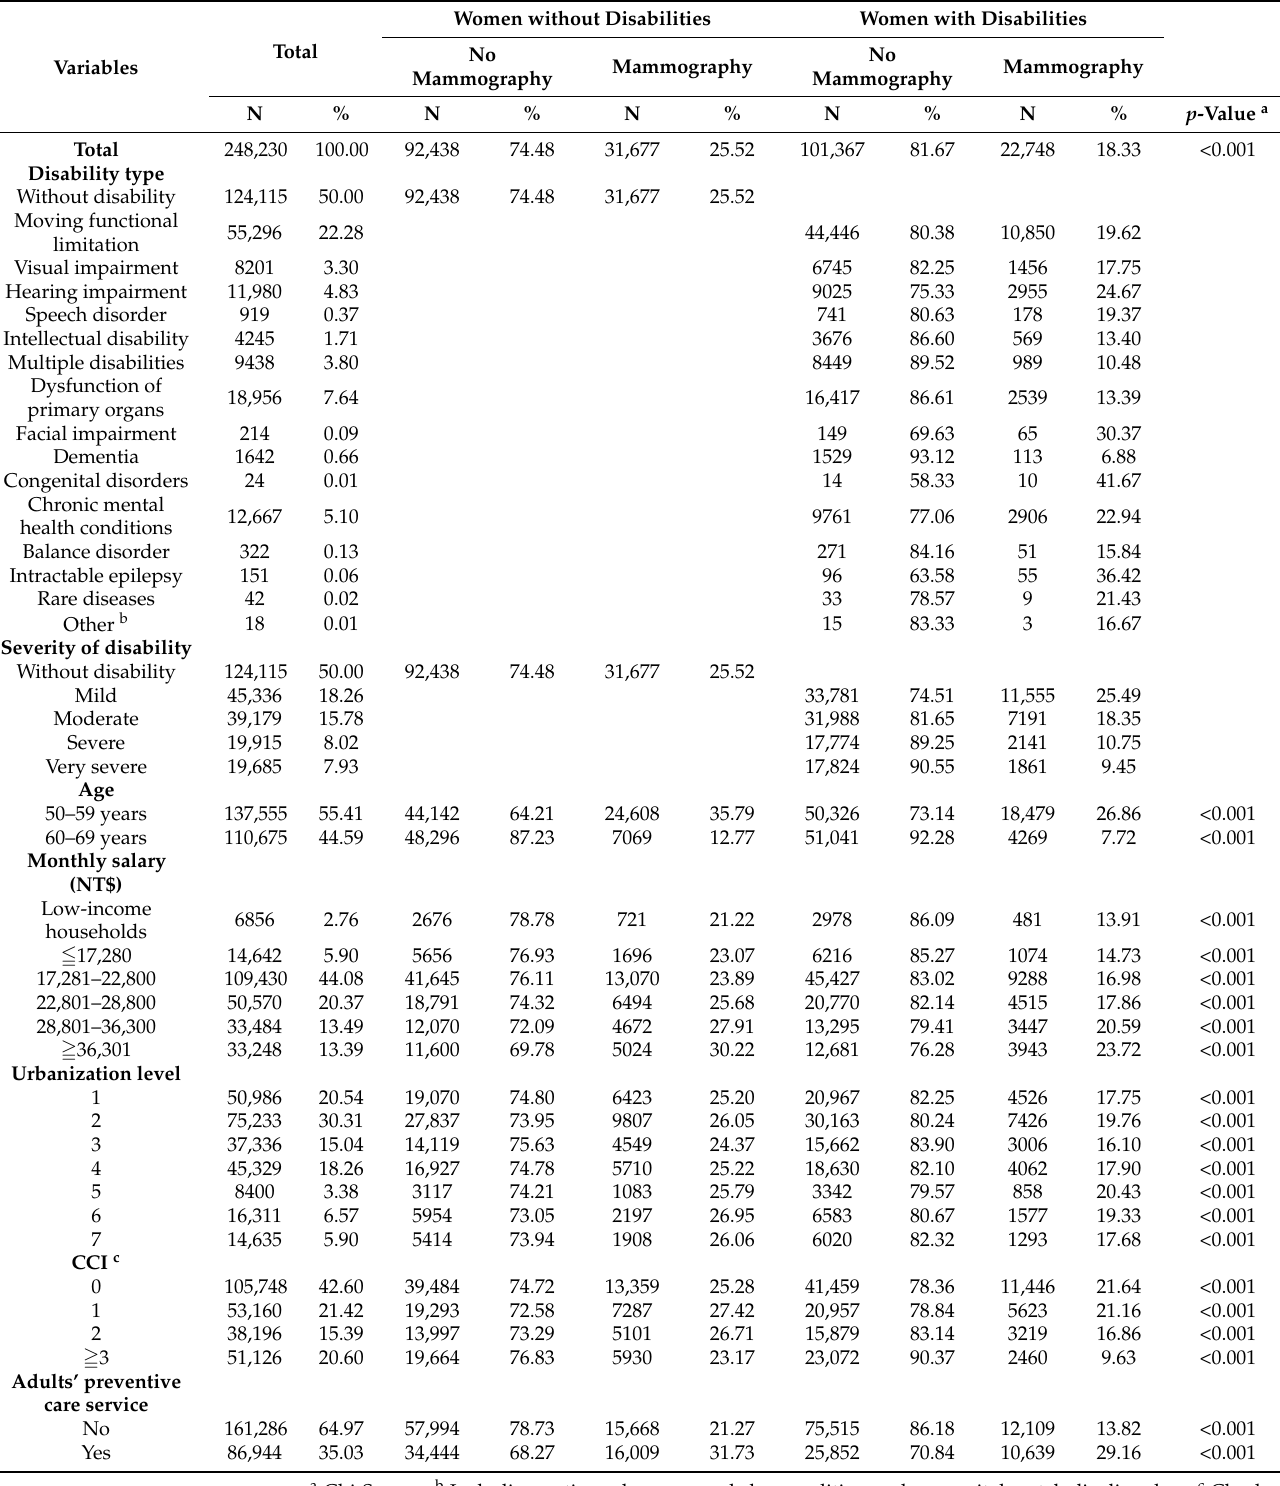
Table 2. Comparison of the use of breast cancer screening between women with disabilities and those without